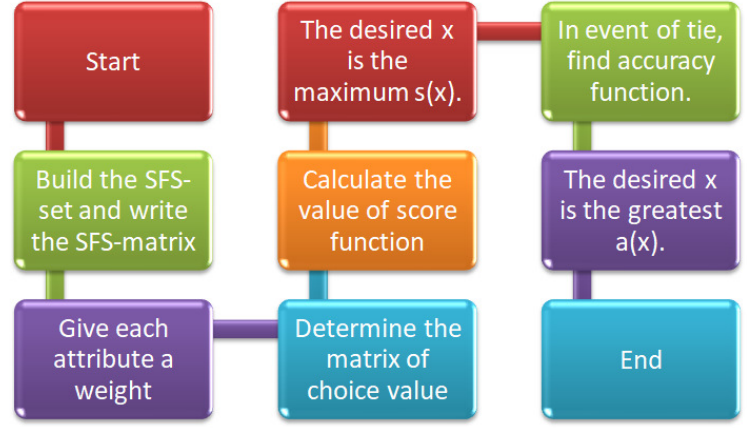
Figure 1. Flow chart of Algorithm